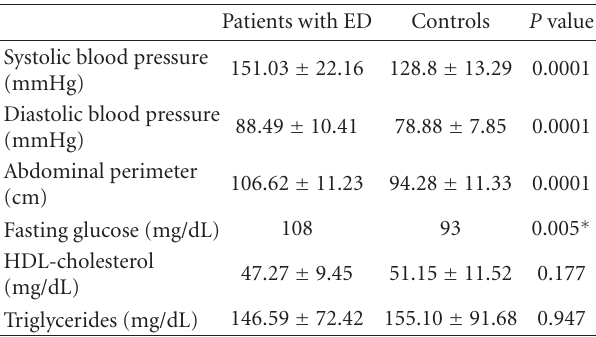
Table 1: Analysis of the ATP-III metabolic syndrome criteria (mean ± SD when normally distributed, median when nonnormally distributed) in patients with ED and their respectively controls.